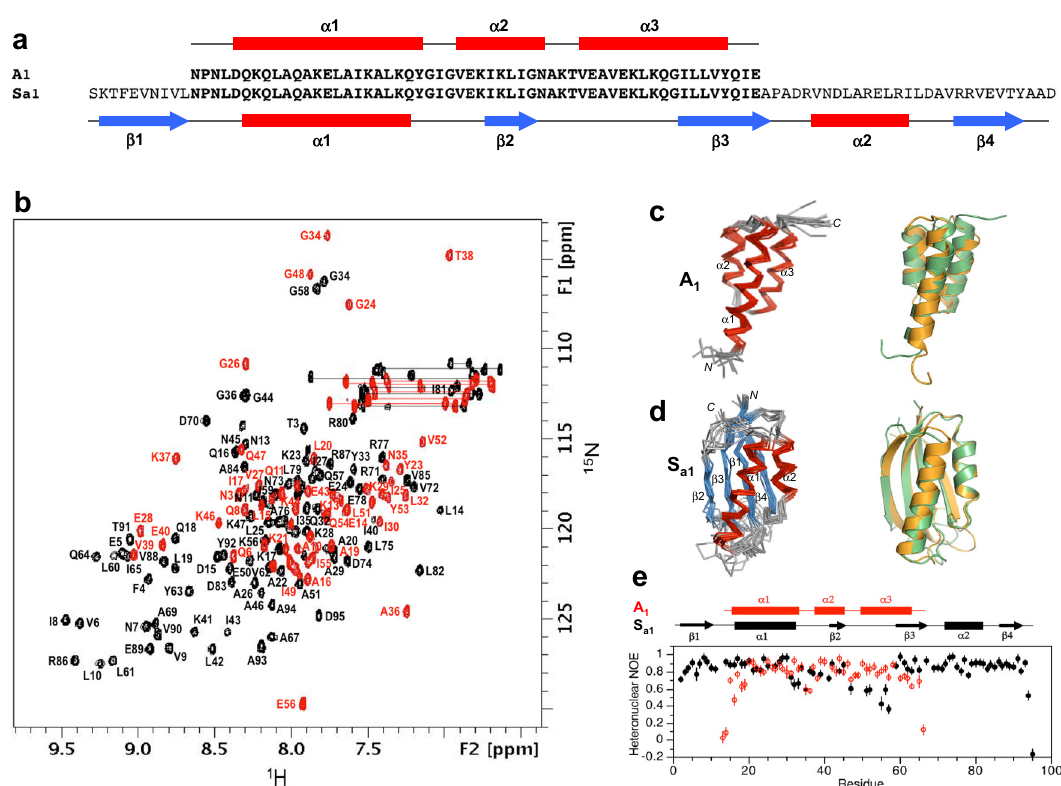
Fig. 3|StructureanddynamicsofA 1 andS a1 .a Sequencealignmentof A 1 andS a1 , which are 100% identical over the 56 amino acid A-region. b Overlaid two- dimensional 1 H- 15 N HSQC spectra of S a1 (black) and A 1 (red) with backbone amide assignments. Spectra were recorded at 25 and 5°C, respectively. c Ensemble of 10 lowest energy CS-Rosetta structures for A 1 (left panel). Superposition of the A 1 structure (green) with the parent G A fold (orange) (right panel). d Ensemble of 10